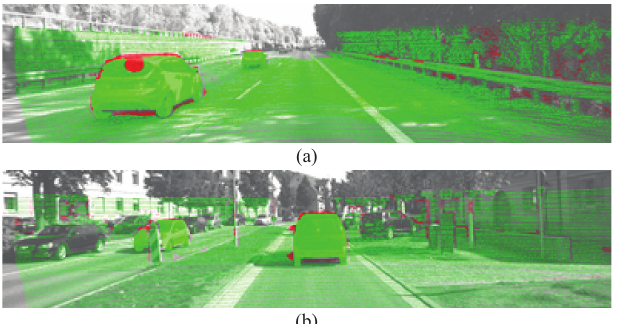
Figure 12. Examples of the disparity results by MC-CNN in [50]: ( a ) error of 3.73%; ( b ) error of